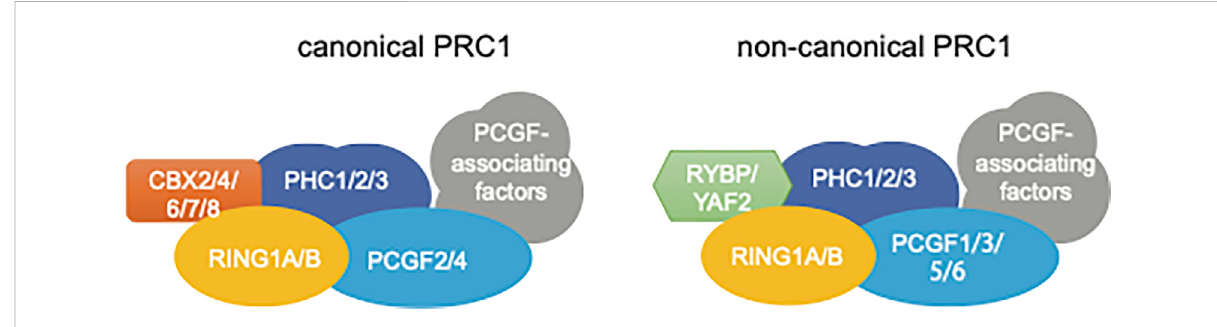
FIGURE 1 SubunitcompositionofPolycombrepressivecomplex1(PRC1),eithercanonicalPRC1(cPRC1,left)ornon-canonicalPRC1(ncPRC1;right).The cPRC1complexiscomposedoffourcoresubunits,includeaRING(eitherRING1AorRING1B),aPHCprotein,aCBX(eitherCBX2,CBX4,CBX6,CBX7, orCBX8), aPCGF (eitherPCGF2 or PCGF4), inaddition toassociatingproteins.ForthencPRC1complex,CBX isreplaced byeitherRYBP orYAF2, the PCGF being either PCGF1, PCGF3, PCGF5, or PCGF6, in addition to other ncPRC1-speci fi c associating